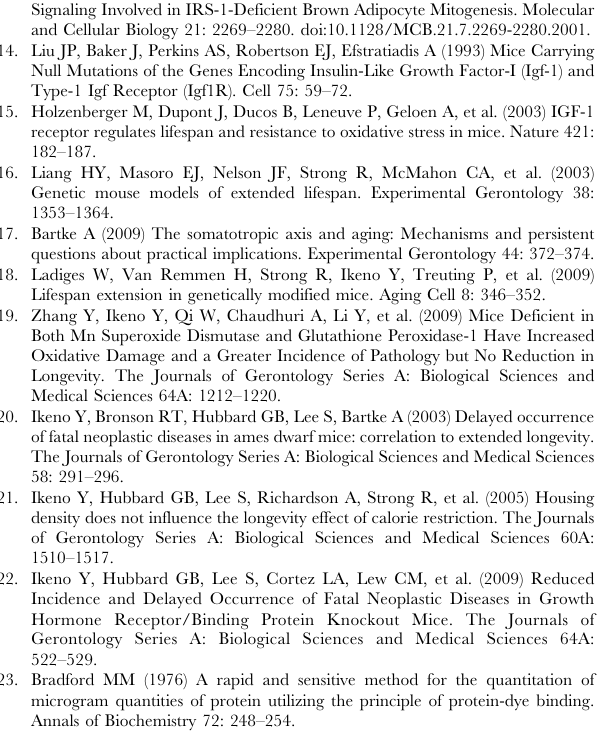
Table S4 Incidence of Lesions in Females. See legend for table S3. Table S5 Males and Females, Severity. Organ-specific lesions (glomerulonephritis, gonadal degeneration, nephrocalcino- sis, pituitary adenoma, and subscapular hyperplasia) were assigned a severity grade as described in Methods by Ikeno et. al. [20–22]. For lymphoma and lymphocytic infiltration, the number of organs where those lesions were observed was used as a measure of whole- organism severity. A logistic regression model was fitted to the organ-specific data and a linear model was fitted to the lymphoma and lymphocytic infiltrate data. In all cases, severity was the response variable and genotype, age and the age-genotype interaction were the covariates. The p-values for the genotype and age-genotype effects were adjusted for multiple comparisons using the Holm method [27]. The raw and adjusted p-values for the genotype effect are shown. None of the age-genotype p-values